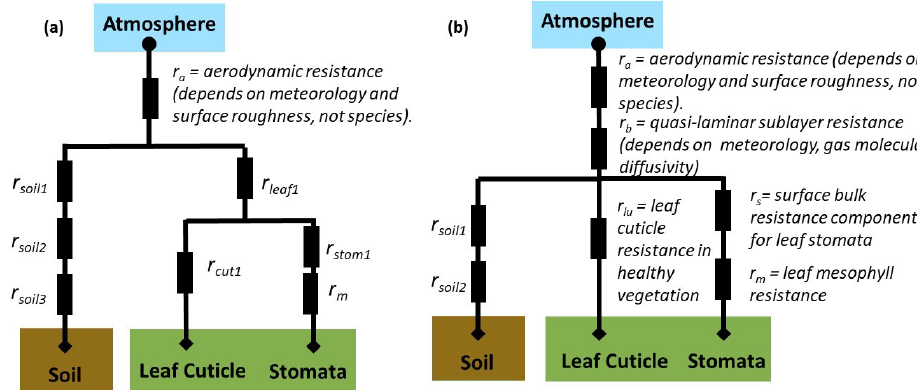
Figure 3. Two generic deposition resistance